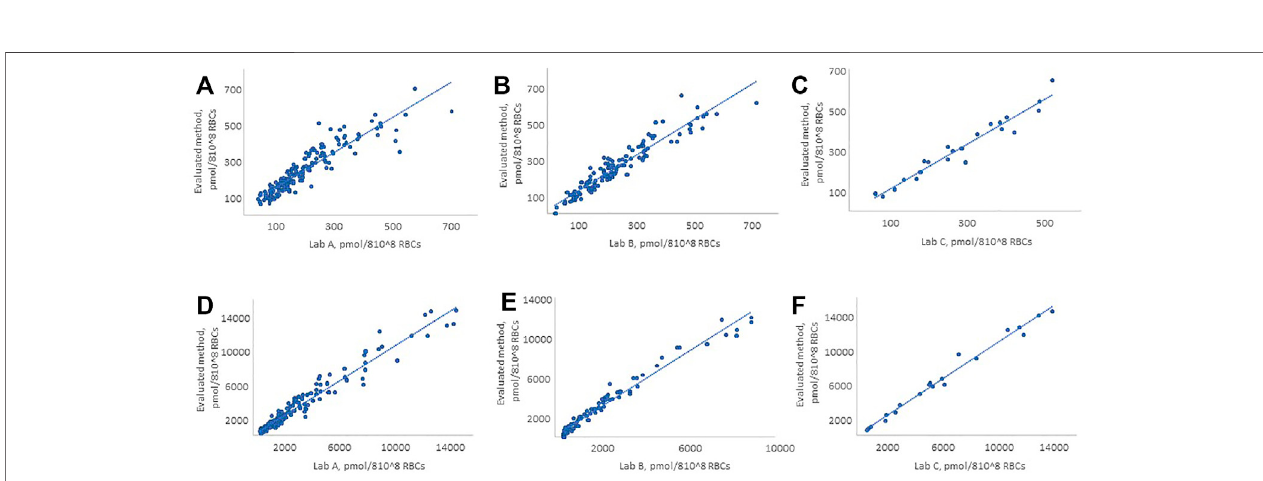
FIGURE2| ComparisonoftheevaluatedmethodwithLC – MS/MSmethodsofLabA,LabB,andLabCfor6-TGand6-MMP. (A,D) 6-TGand6-MMPcomparison with Lab A, (B, E) 6-TG and 6-MMP comparison with Lab B, and (C, F) 6-TG and 6-MMP comparison with Lab C. The fi gure shows only the patient samples where the observed concentrations were within the analytical measurement range of the method.